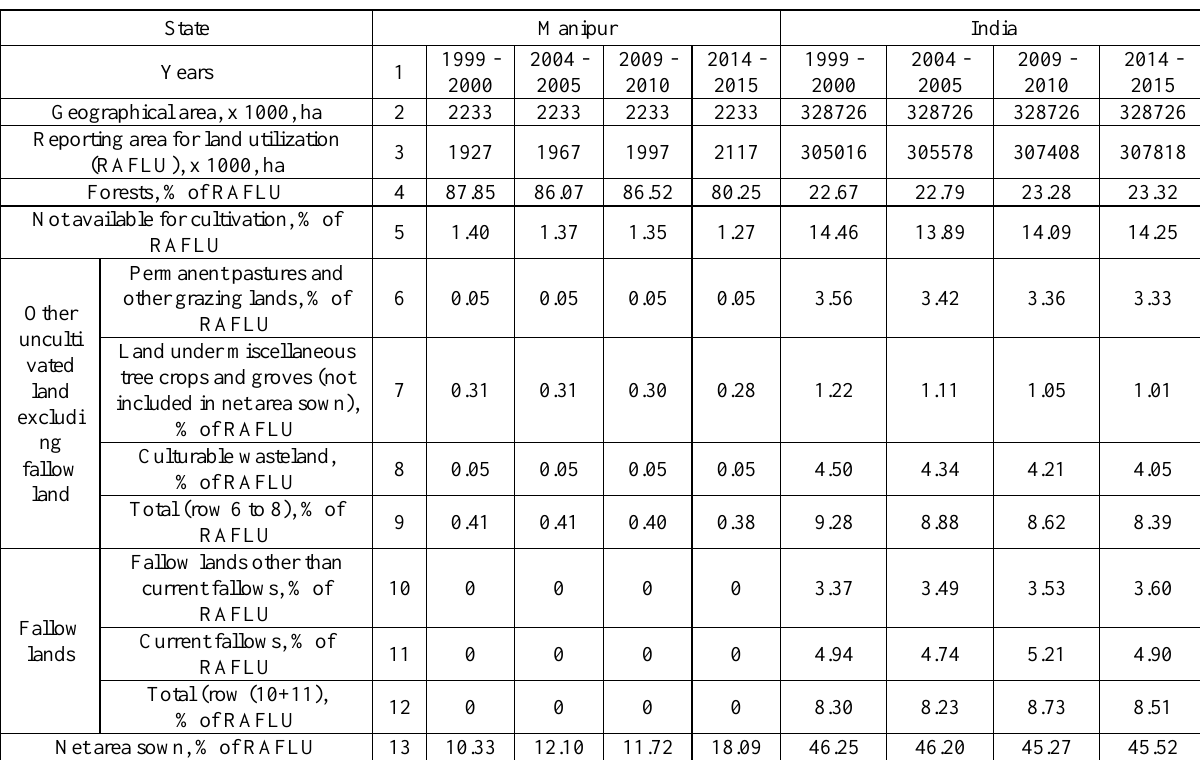
Table 1. Land use pattern (Manipur and India) [21, 22]